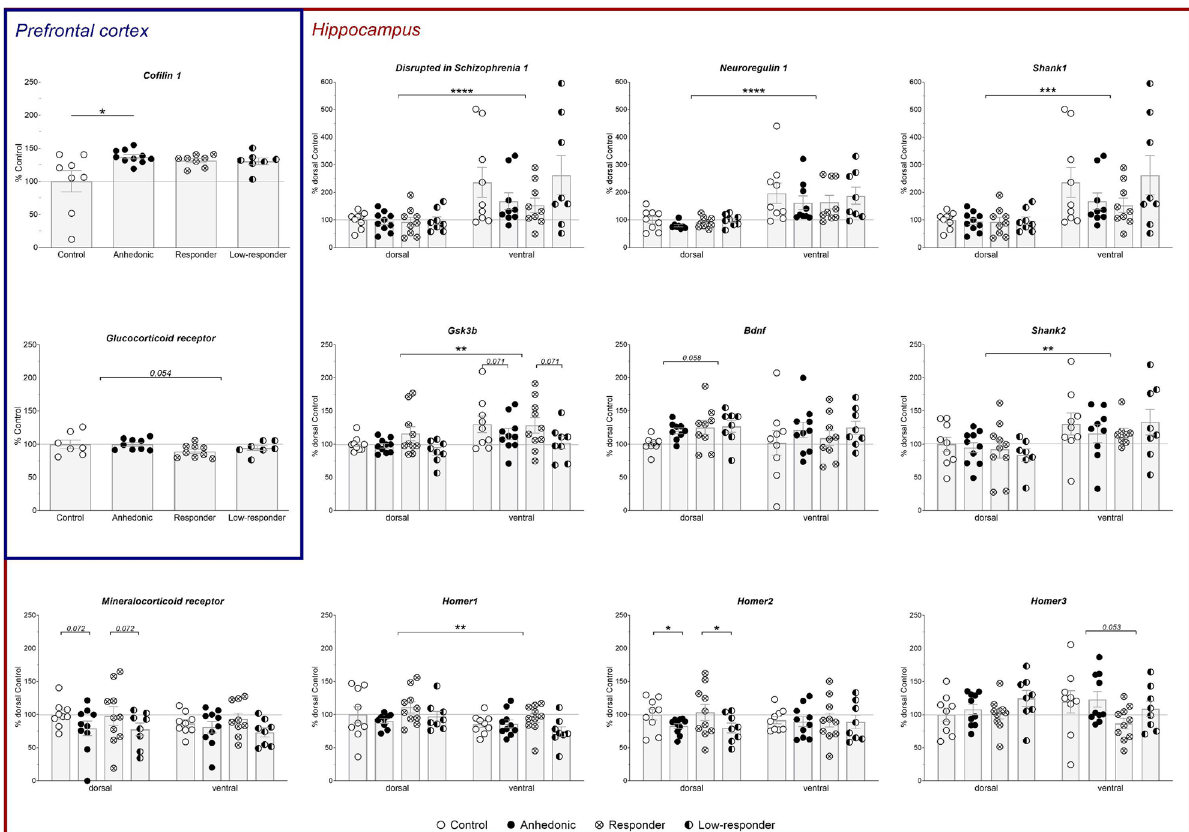
Figure 5. Prefrontal cortex (PFC) and hippocampal (HPC) gene expression levels. Genes of interest are normalised to reference genes and displayed as percent of control mean for the PFC or as percent of the control mean of the dorsal HPC for ventral and dorsal HPC tissue. Individual data points as well as group means (± SEM) are displayed. Statistical significance is indicated for main effects and between tissue differences (angular brackets), and Bonferroni corrected post-hoc comparisons by **** p < 0.0001, *** p < 0.001, ** p < 0.01, * p < 0.05; and trends by the respective number. Bdnf —Brain-derived neurotrophic factor; Disc1 —Disrupted in Schizophrenia 1; Gsk3b —Glycogen synthase kinase 3 beta; Homer —Homer scaffolding protein; Nr3c1 — Glucocorticoid receptor; Nr3c2 —Mineralocorticoid receptor; Nrg1 —Neuroregulin